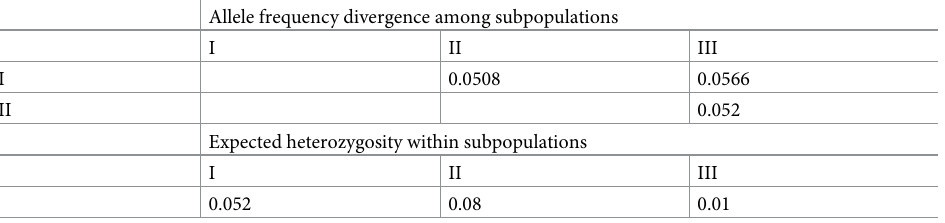
Table 6. Allele frequency divergence among sub-populations and expected heterozygosity (average distance) between genotypes with in the same subpopulations. Allele frequency divergence among subpopulations